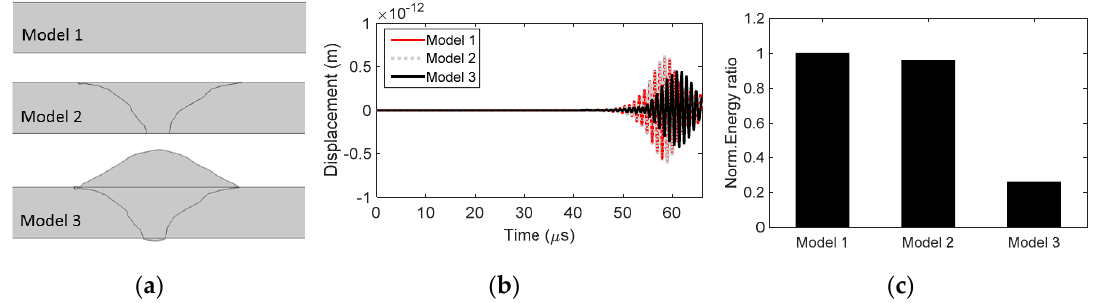
Figure 12. ( a ) The numerical profiles of three models, ( b ) their waveforms and ( c ) the normalized UT energy ratios.